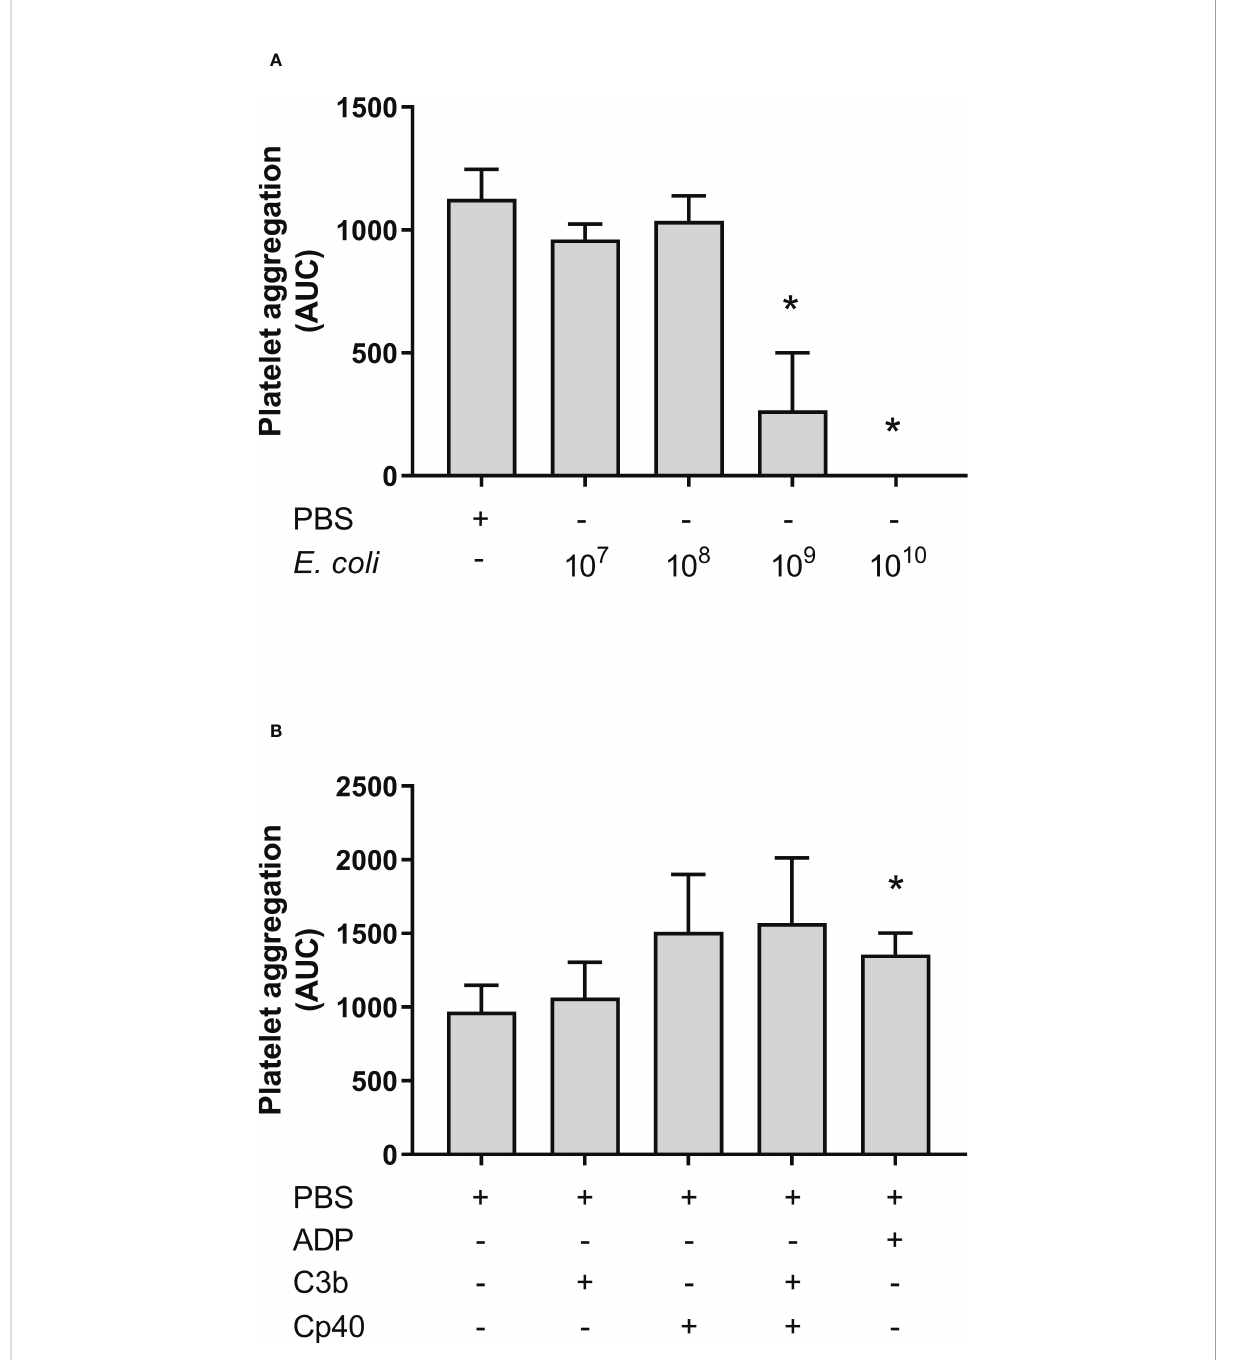
FIGURE 5 Platelet aggregation with isolated platelets in Tyrode ’ s buffer was measured by Multiplate ® impedance aggregometry. The platelets were isolated by centrifugation and washed using Tyrode ’ s buffer. The samples were added phosphate-buffered saline (PBS) or Escherichia coli ( E. coli ) in PBS in increasing concentrations as indicated; 1 x 10 7 /mL, 1 x 10 8 /mL, 1 x 10 9 /mL, and 1 x 10 10 /mL, n = 3 (A) . *; p < 0.05 analyzed using one-way repeated measurements ANOVA, and Dunnett ’ s multiple comparisons test, comparing samples with increasing E. coli concentrations to the lowest E. coli concentration (1 x 10 7 /mL). The effect of C3b on aggregation of isolated platelets were analyzed (B) . To the samples were either added PBS, C3b (20 nM), compstatin (Cp40, 20 µM) or a combination of them. Adenosine diphosphate (ADP) was added as a positive control. The results are given as the area under the curve (AUC), using mean ± standard deviation (n = 5). *; p < 0.05 analyzed using one-way ANOVA repeated measurements, and Dunnett ’ s multiple comparisons test, comparing the PBS control to the other